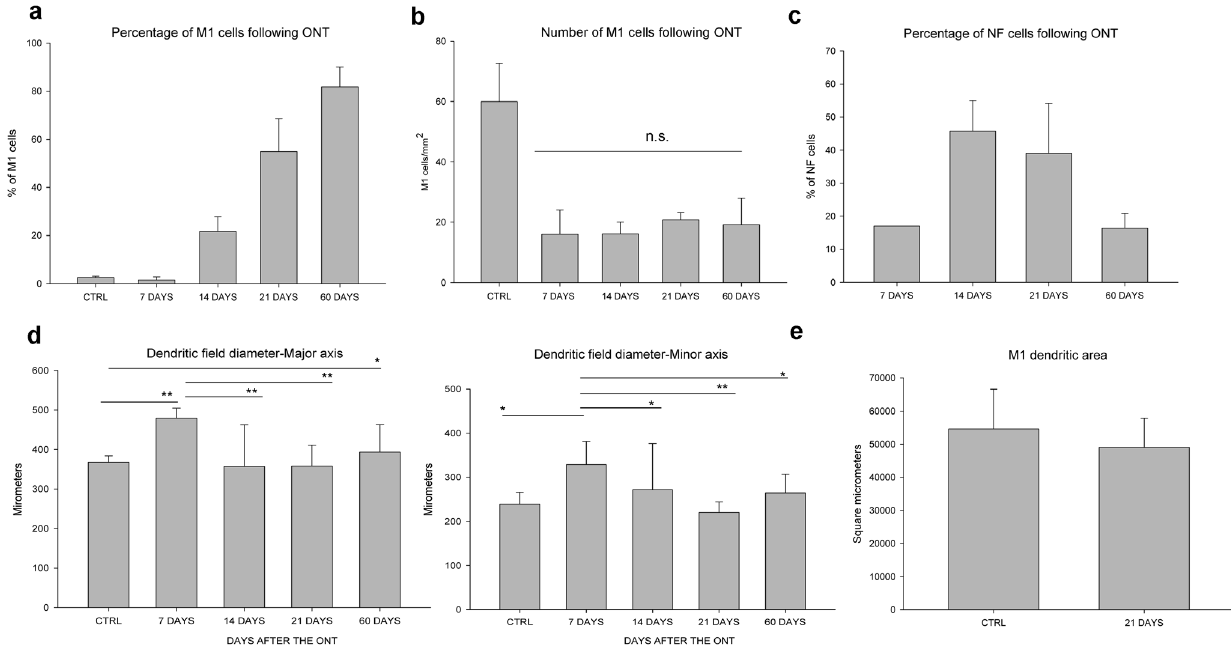
Figure 3. Characterization of surviving M1 and neurofilament-M ganglion cells. Surviving M1 (a) and neurofilament-M ganglion cells (c) compared to the number of RBPMS immunoreactive cells after axotomy. (b) Number of M1 ganglion cells/mm 2 . (d) Dendritic field diameter measurements and (e) Dendritic area of M1 ganglion cells remain unchanged 21 days after axotomy. n.s=no significance, * indicates P , 0.05 and ** P ,